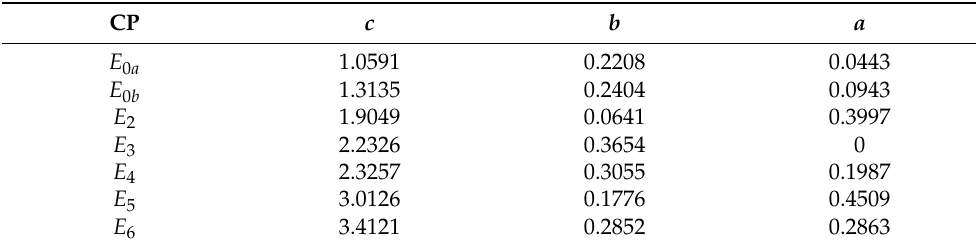
Table 3. Fitted parameter values of quadratic equations for allowing composition dependences of the CP energies along the zigzag direction to be